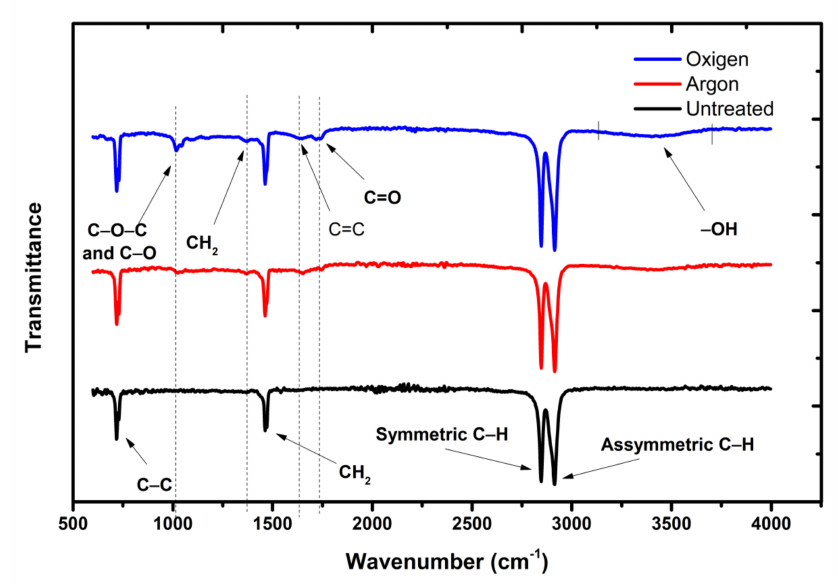
Figure 6. FTIR of the treated samples and the standard sample.